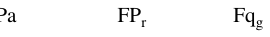
calculated parameters of case#2 by FDGRS simulator